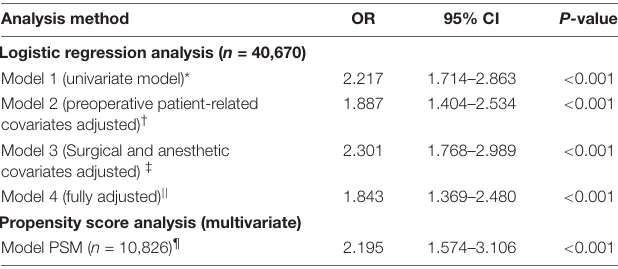
TABLE 2 | Association between SII and perioperative ischemic stroke using the logistic regression model and propensity score analysis. Analysis